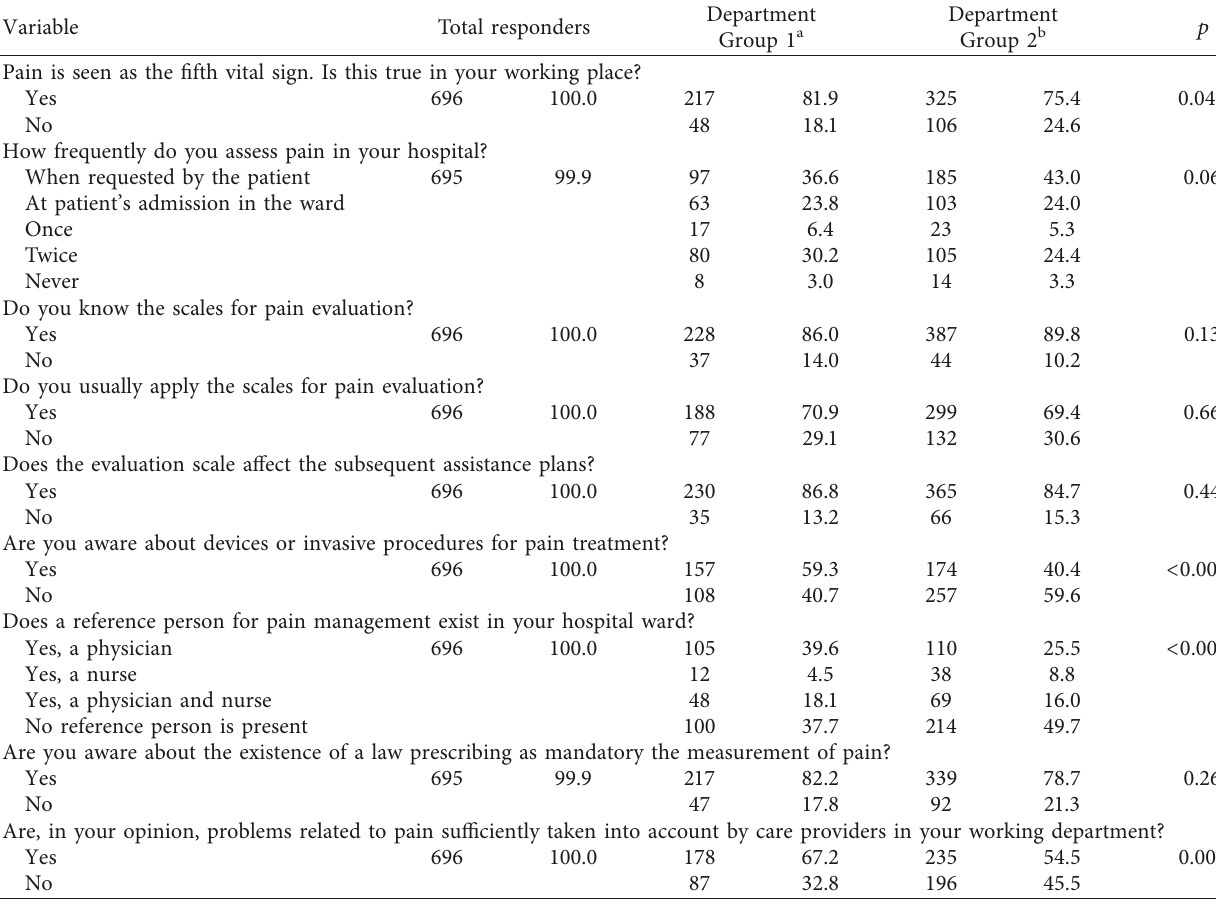
Table 3: Evaluation of pain according to affiliation of departments